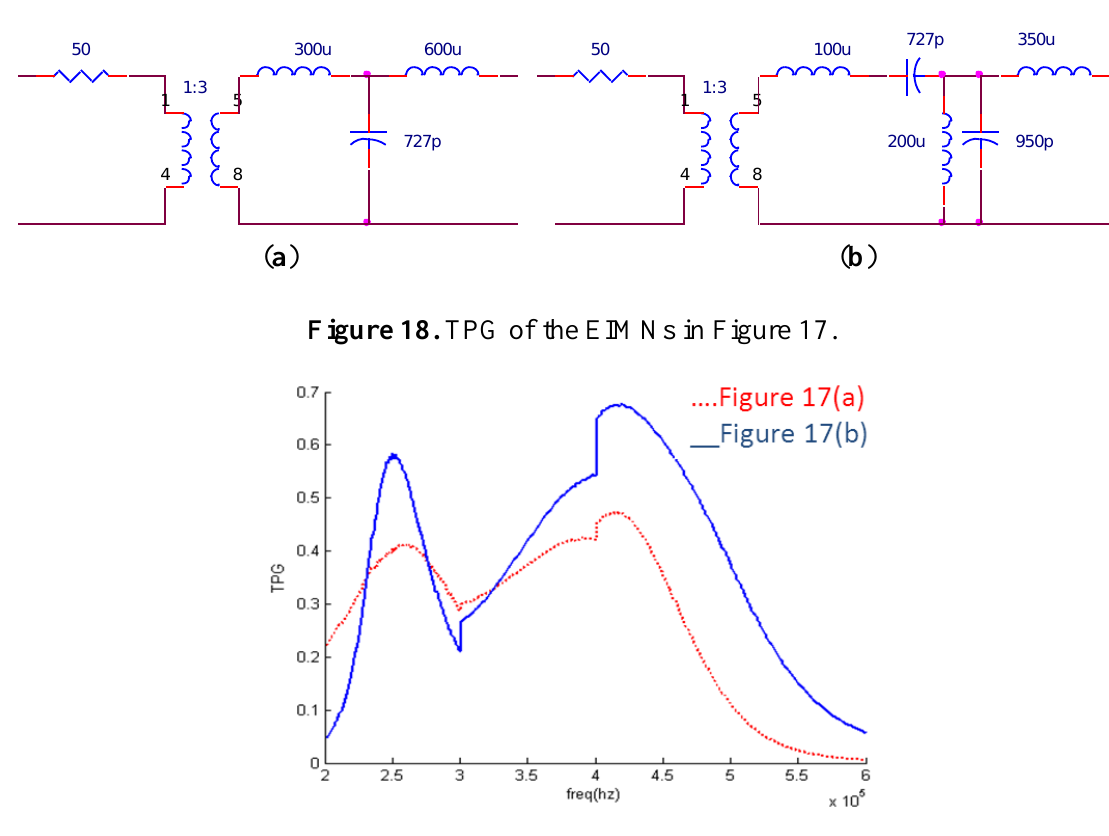
Figure 17. Topologies that the transformer turns ratio is 1:3 ( a ) RFT; ( b ) algorithm introduced in Section 2.